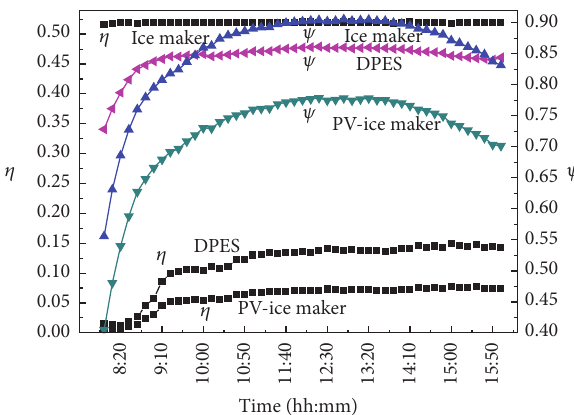
Figure 4: Energy efficiency and exergy efficiency of ice maker driven by DPES.